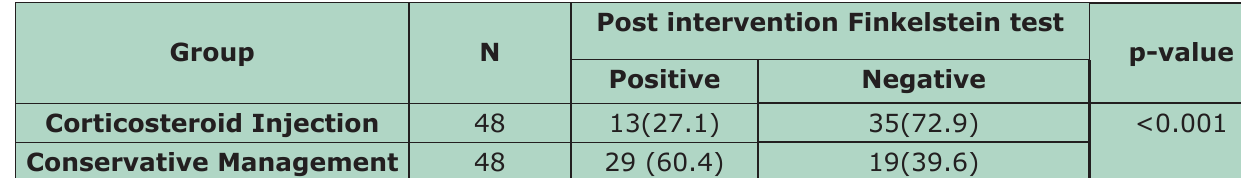
Table-I: Comparing the Post-Intervention Finkelstein Test